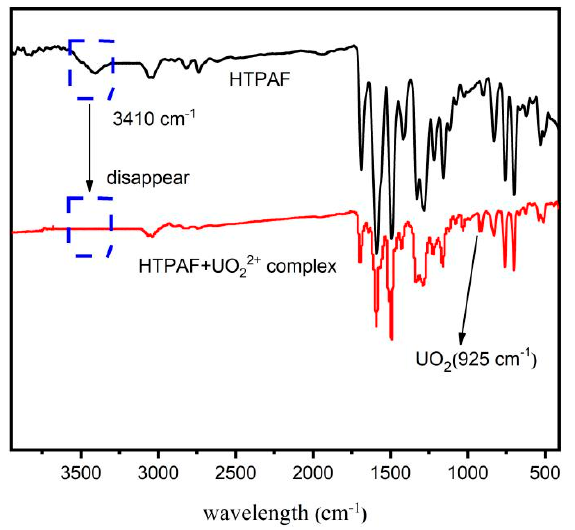
Figure 11. Comparison of infrared spectra before and after the combination of HTPAF and UO 22+ .